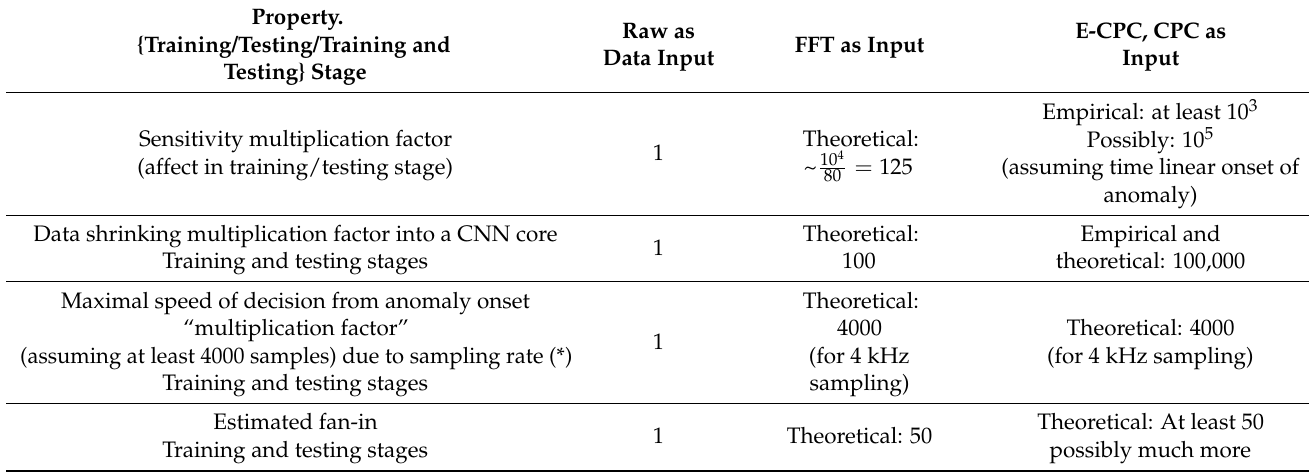
Table 2. Comparative performance report between three models combined with the CNN classification core.